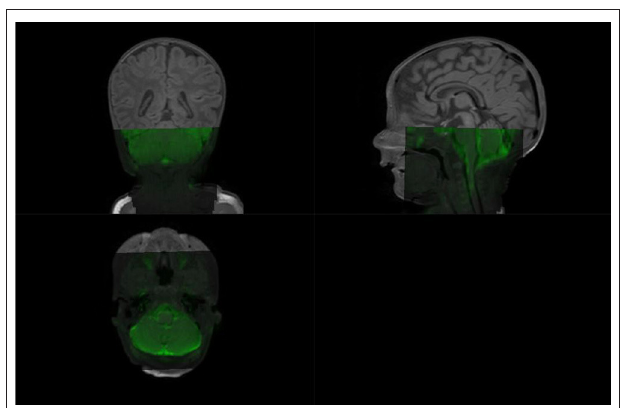
FIGURE 5 | Diffusion kurtosis imaging scan overlaid on structural 3dT1w image: while both images are clearly not registered along the antero-posterior direction due to the very strong susceptibility artifact, the z-location is similar: see how the bottom tip of the cerebellum is consistent for the two scans.